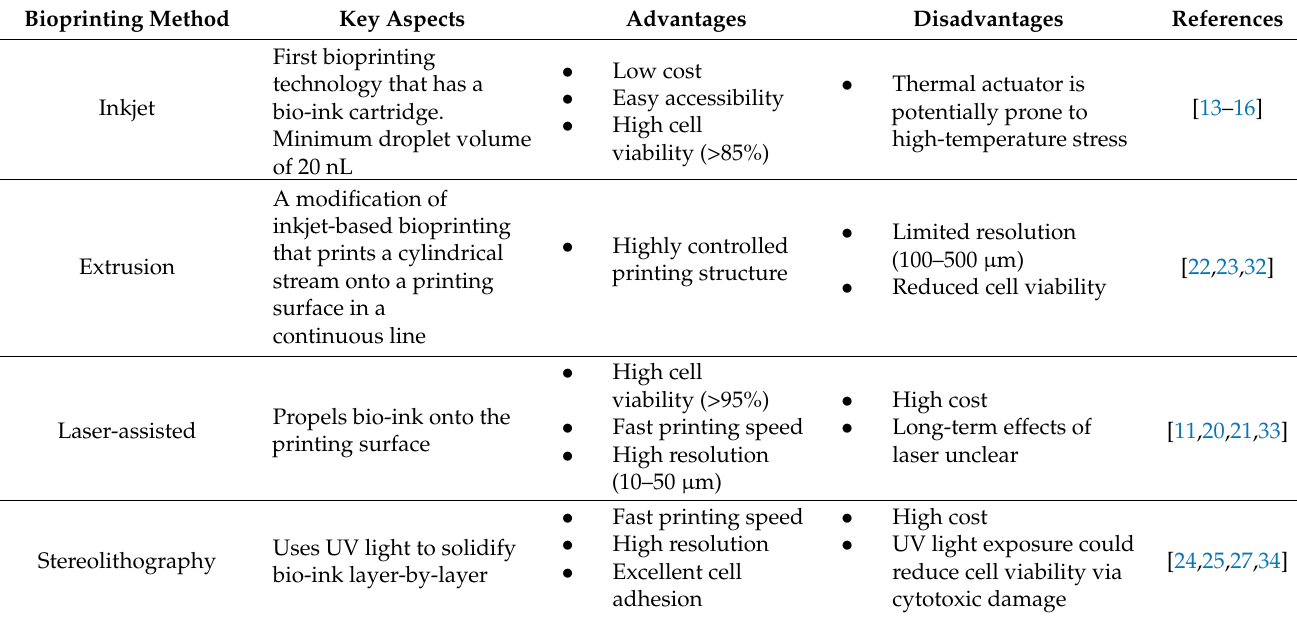
Table 1. Comparison of four major types of bioprinting techniques.